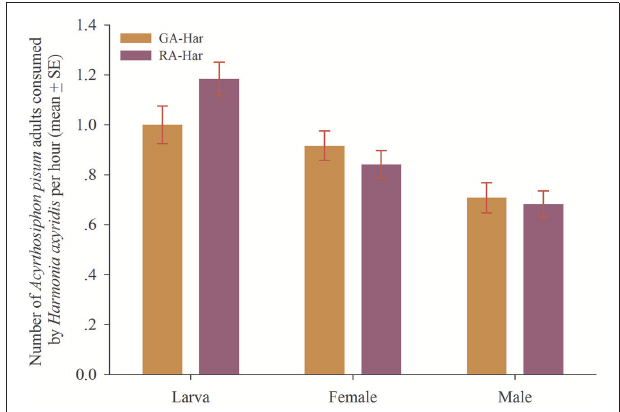
FIGURE 2 | Predation capacity of H. axyridis on the red and the green morphs of A. pisum . The two lady beetle colonies were named as RA-Har and GA-Har, respectively.